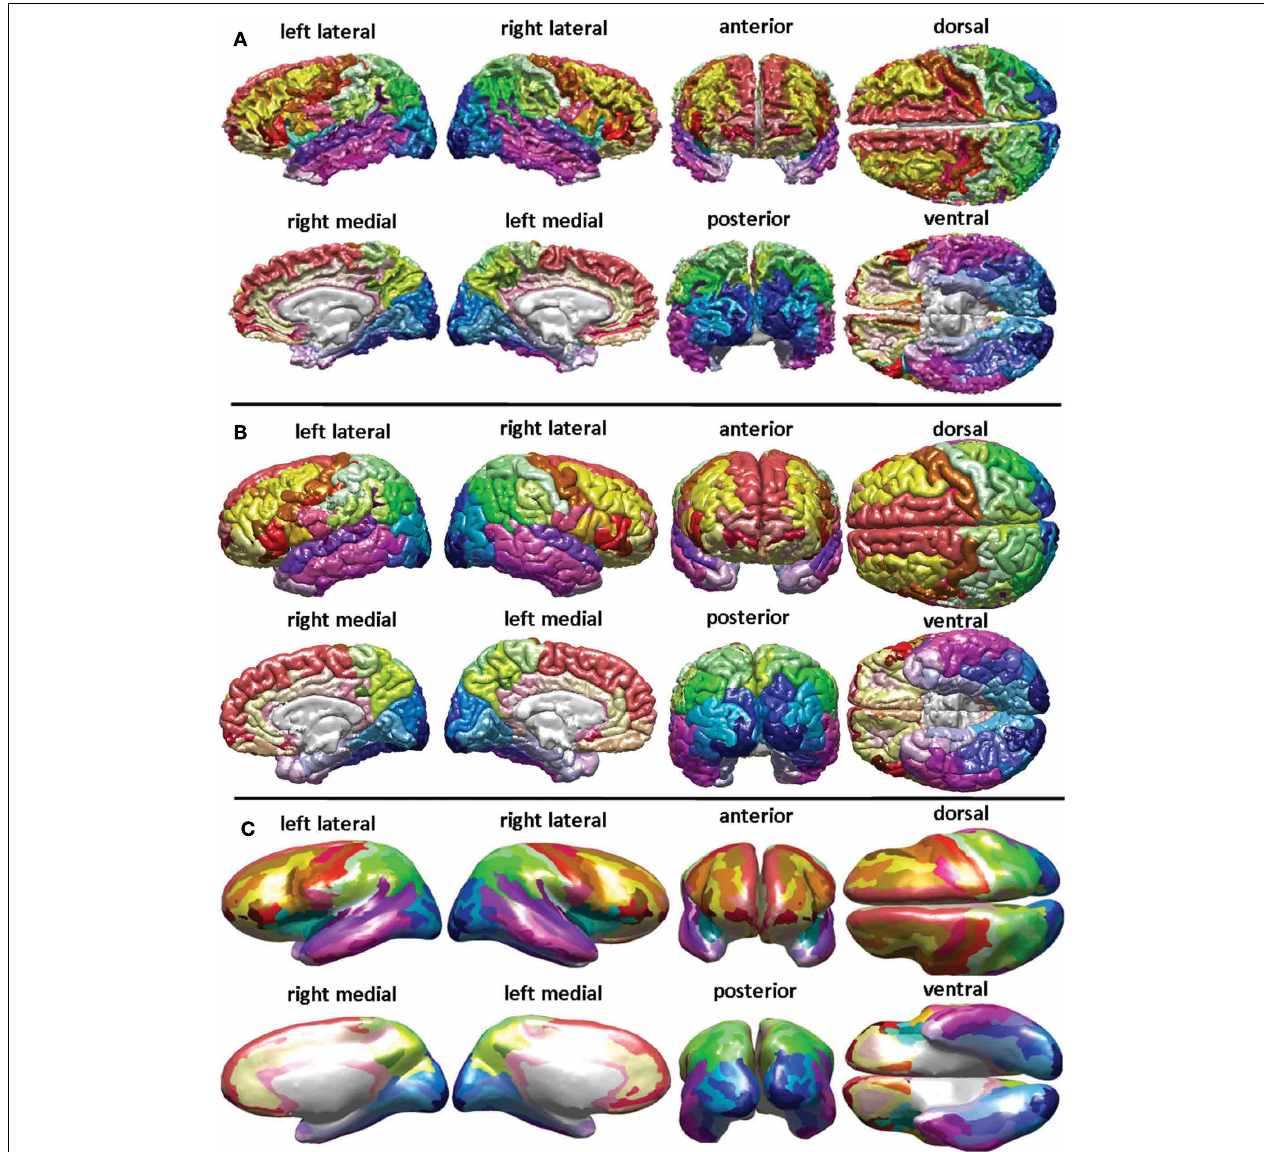
FIGURE 3 | FreeSurfer parcelation of a sample brain. Displayed are the surface corresponding to theWM–GM interface (A) , the pial surface (B) , and the inflated surface (C) , with each parcelated anatomical region displayed in a different color according to the color labeling methodology described in the Section “Methods” (see also